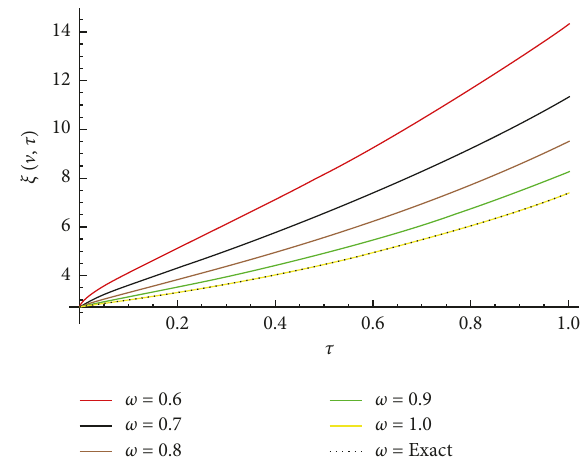
Figure 7: Approximate solutions for different values.